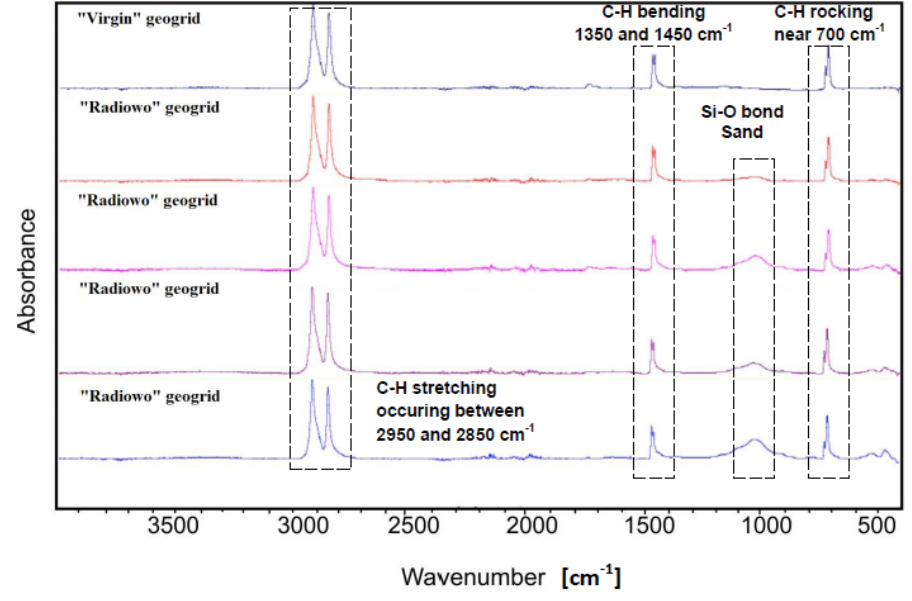
Figure 7. Collected Fourier transform infrared (FT-IR) spectra of virgin geogrid samples and aged geogrid samples (Radiowo).